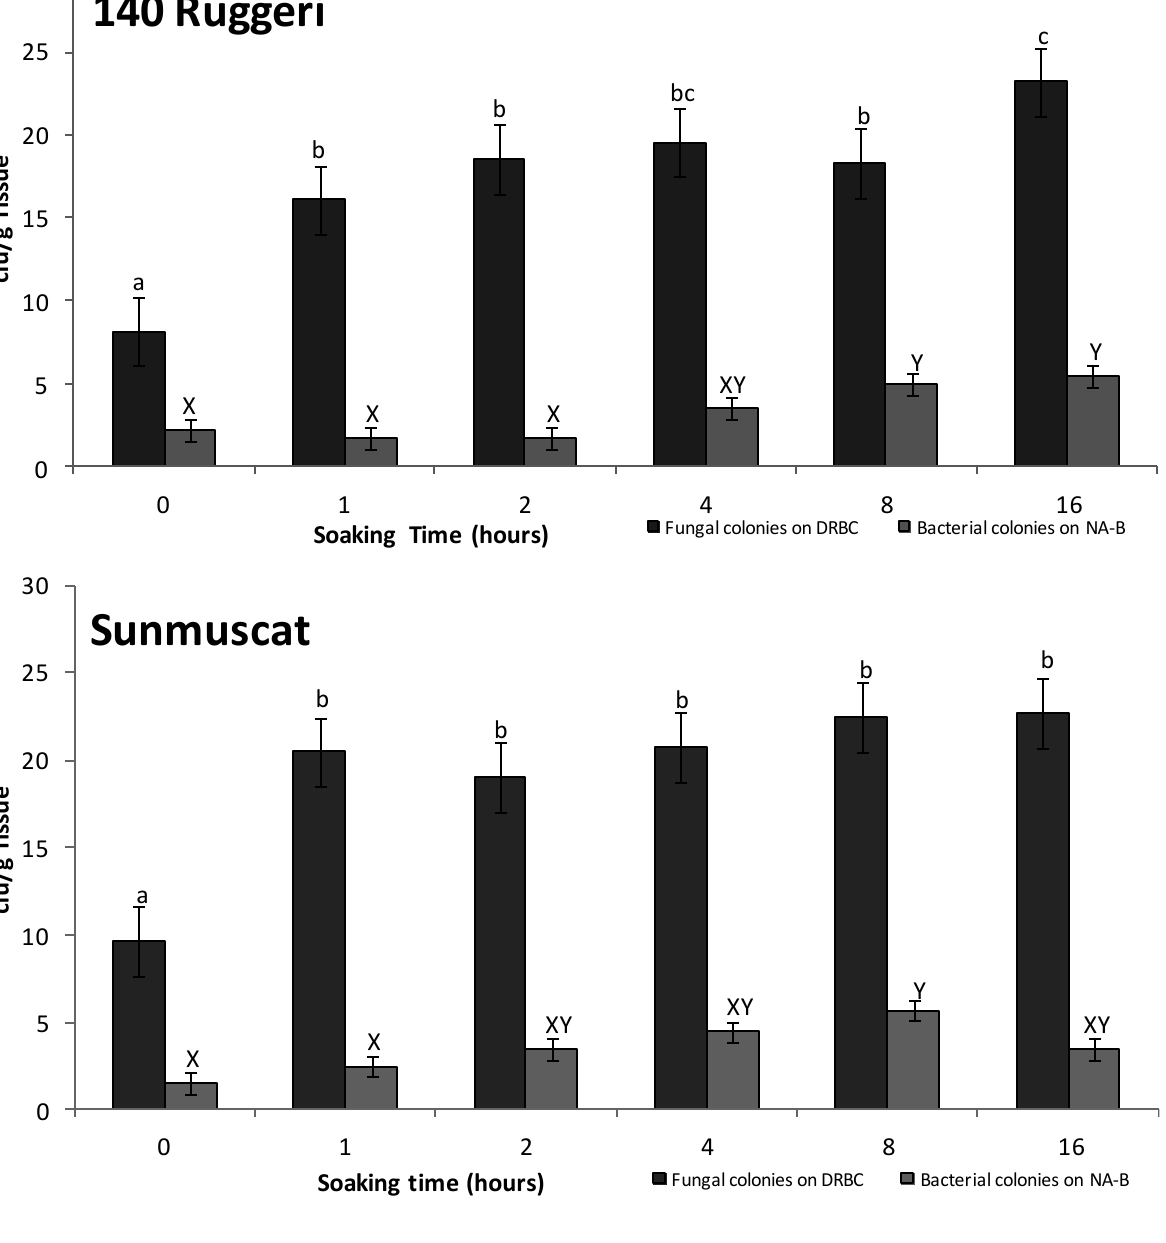
Figure 1. Fungi and bacteria isolated from rootstock 140 Ruggeri and V. vinifera cv. Sunmuscat after different periods of soaking. Vertical bars are the standard error of the means. letters are for comparison of means of fungal colonies (a, b) and bacterial colonies (X, Y). Bars with a different letter are significantly different according to the Student’s Least Significant Difference ( P